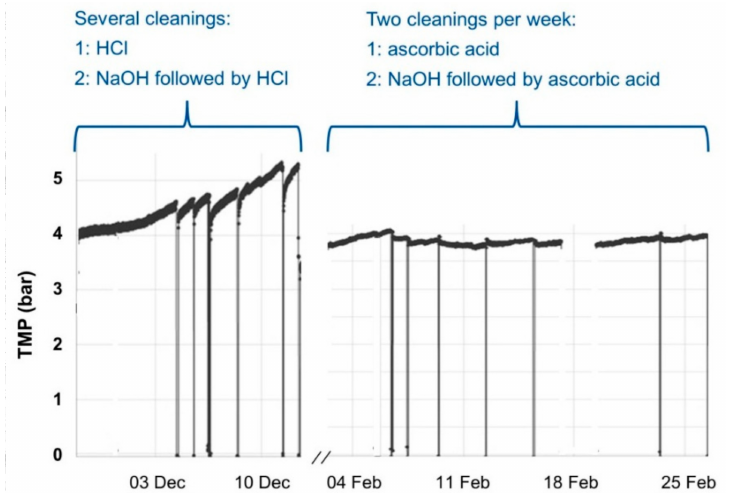
Figure 7. TMP trend and cleaning strategies; well water as feed water source, flux 22.5 L/m 2 h, rec 75%, cfv 0.5 m/s. each vertical line marks a chemical